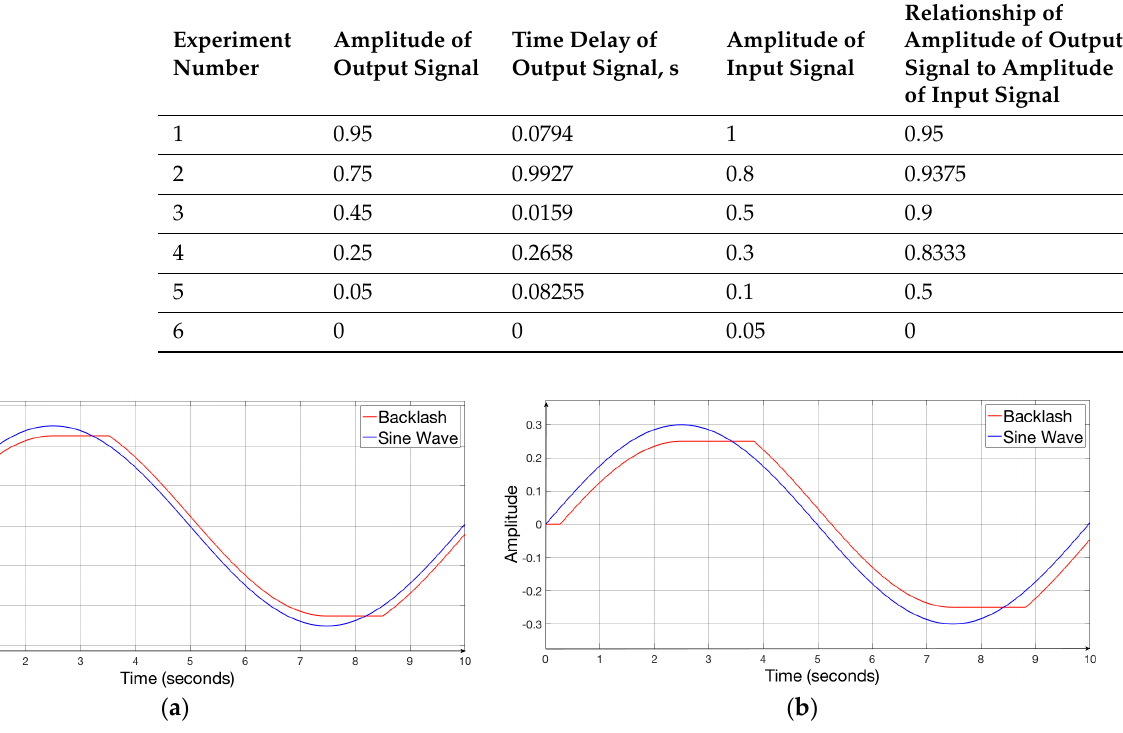
Figure 20. Simulation of cases 3 ( a ) and 4 ( b ). Amplitude is variable. Graph of the output signal amplitude ratio to the input signal amplitude on the amplitude of the input signal is presented in Figure 21. This dependence is used in the analysis of stability.